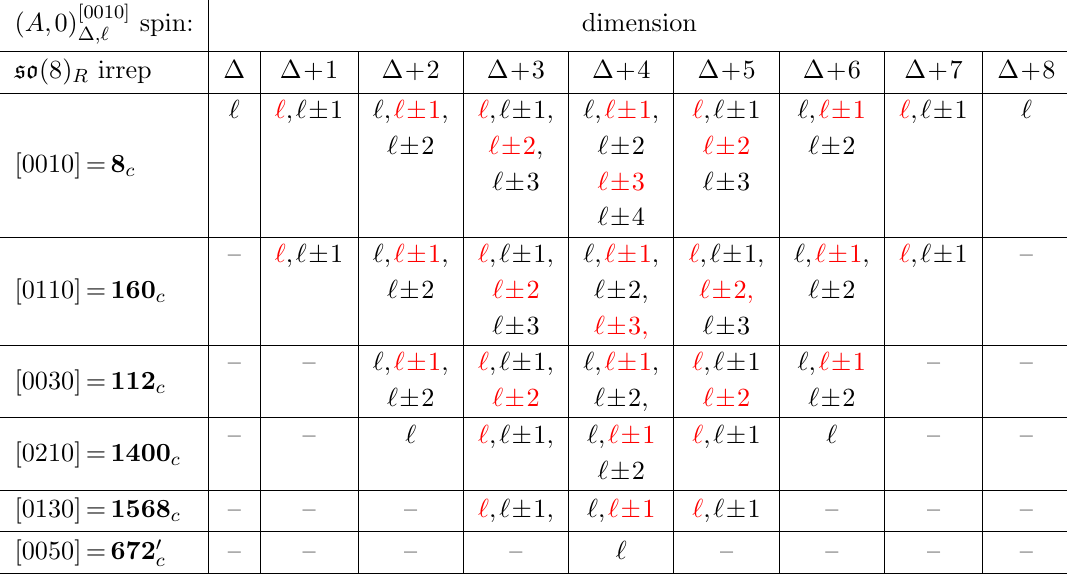
Table 18 . All possible conformal primaries in S 2 (cid:2) S 3 corresponding to the ( A; 0) [0010]